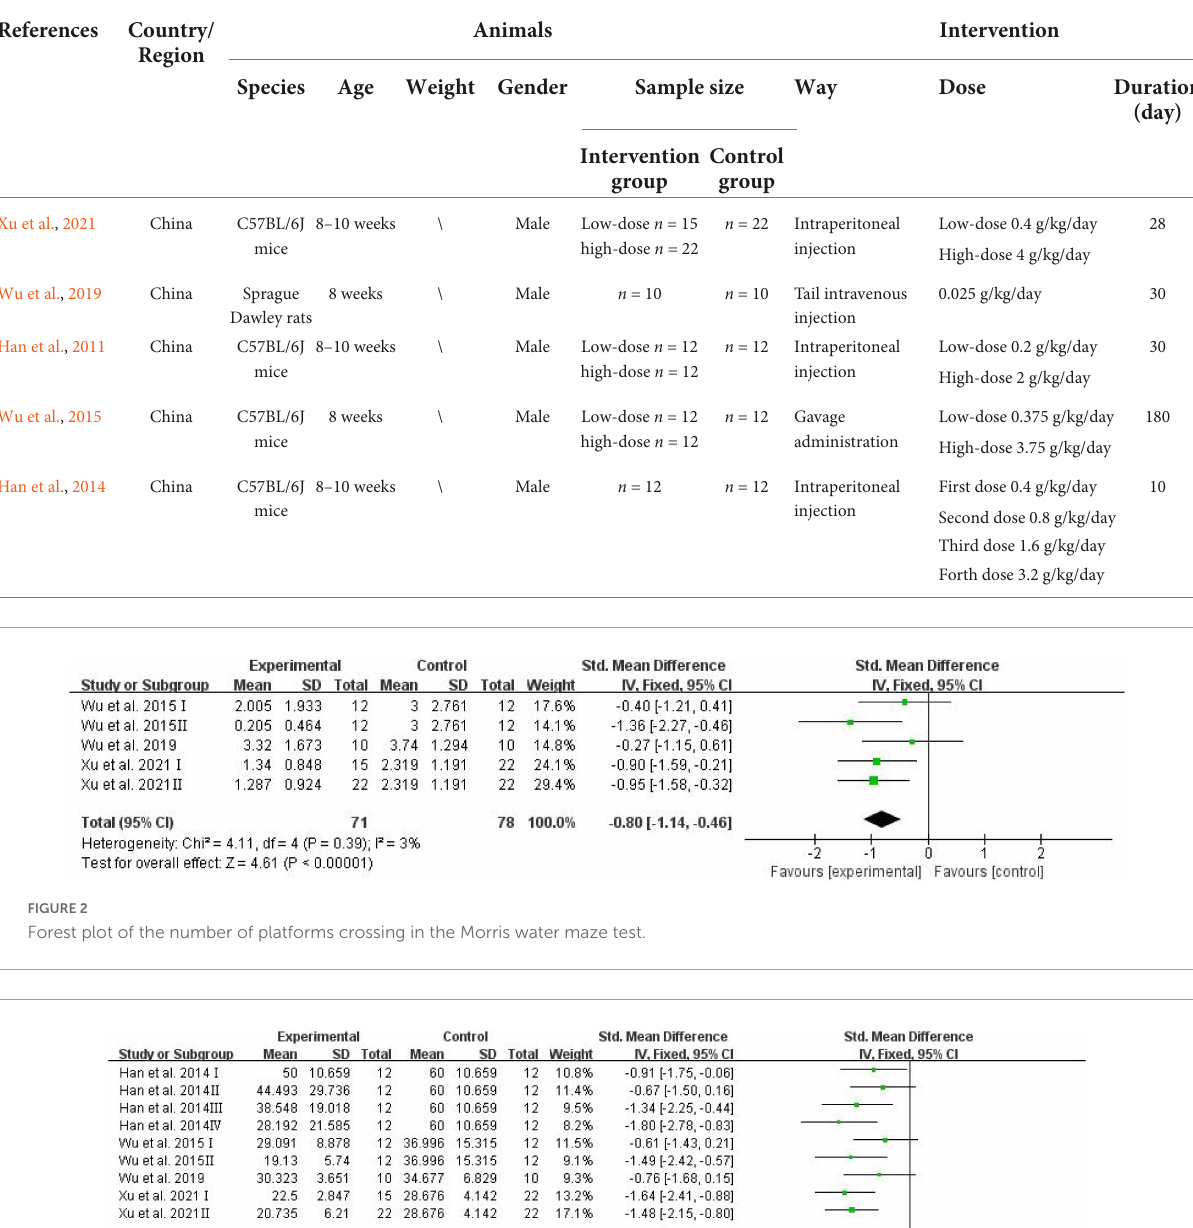
TABLE 1 Characteristics of the included studies.